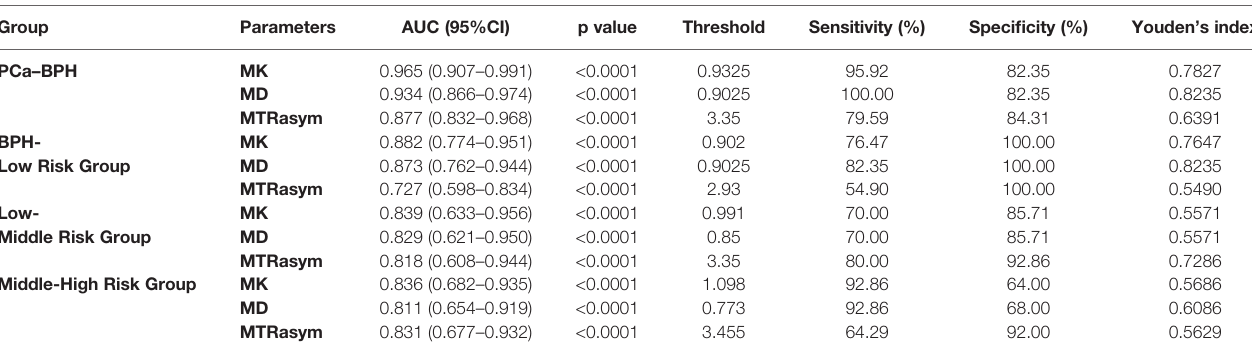
TABLE 4 | Parameters of ROC